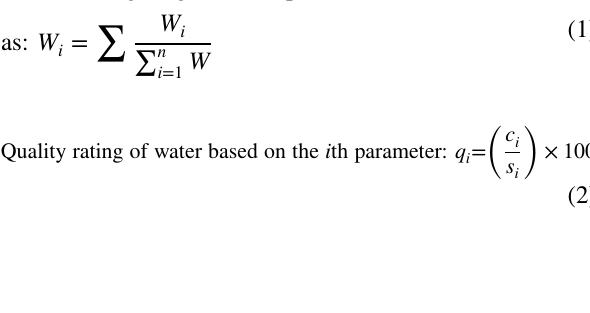
Fig. 2 a Spatial distribution of potassium ions ( K + ) in the pond, surface water and underground water bodies in ppm, in and around the Dhanbad district of Jharkhand represented by contour mapping,